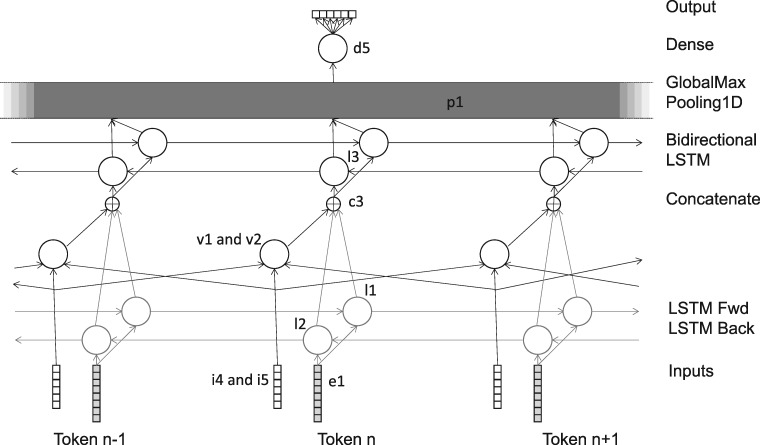
Recognition network.